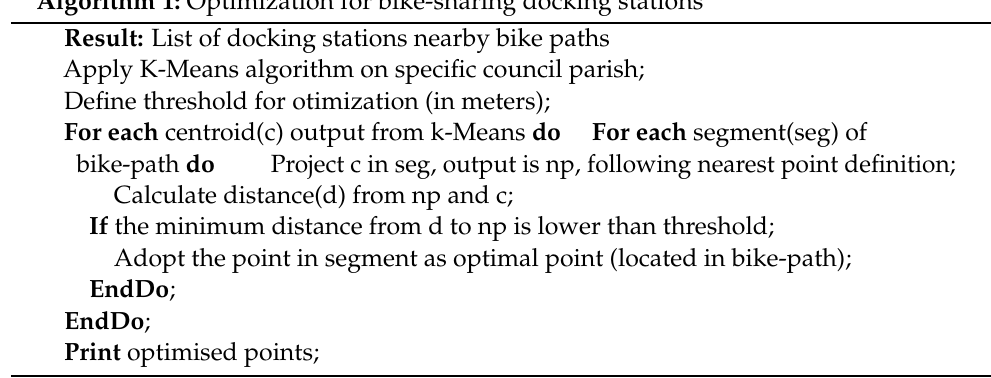
Algorithm 1: Optimization for bike-sharing docking stations